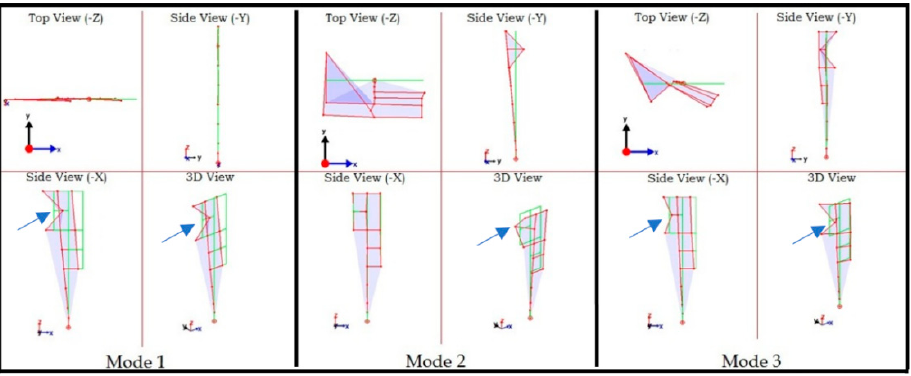
Figure 18. First three mode shapes after applying the time lags of the first iteration. (Note that node #5, identified by an arrow in the side view diagrams, seems to be out of synchronicity).